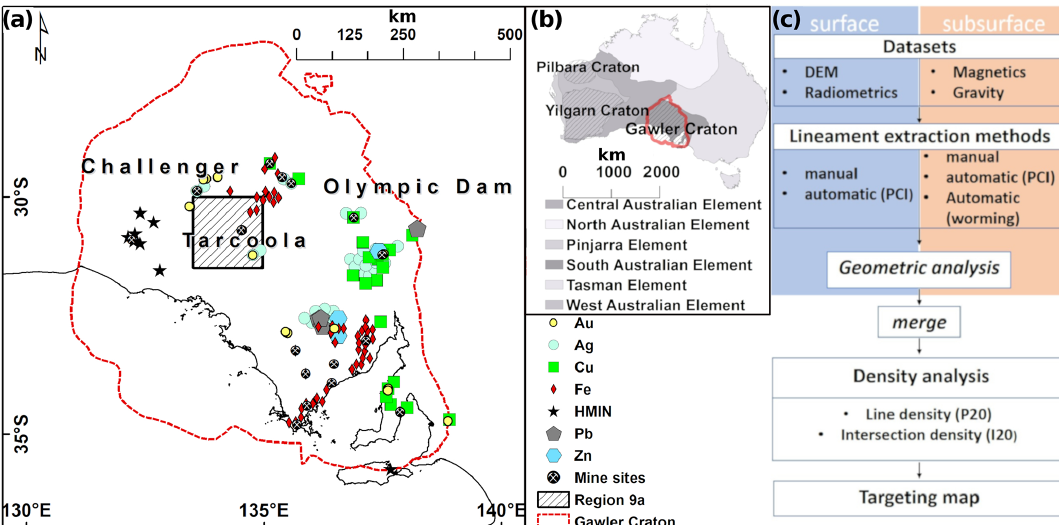
Figure 1. (a) Economic mineral occurrences in the Gawler Craton. The mineral commodities include Au, Ag, Cu Fe, HMIN (heavy minerals), Pb, and Zn. (b) Overview map of the Australian continent showing the major crustal blocks and the locations of mineral-rich Archean to Proterozoic tectonic provinces. The Gawler Craton spans across nearly the entire South Australian Crustal element. (c) Outline of the workflow applied in this study to obtain targeting maps from surface and subsurface datasets. The first step is to categorise the datasets based on their penetration depth into surface and subsurface signals. Lineaments are then extracted with the methods outlined in Sect. 3.3, 3.4, and 3.5. Note that the multi-scale edge detection (“worming”) is only applied to the magnetic and gravity data, manual segmentation was only performed on the DEM, and automatic lineament mapping with the PCI Geomatica LINE module was applied to all datasets. We performed a geometric analysis on the extracted lineaments to highlight the variability between the different methods (Fig. 11). Targeting maps are derived from computed line density and intersection density maps. The first step for obtaining these maps is to merge lineaments into a single dataset if the lineaments are extracted with the same method. This is performed for surface and subsurface lineaments respectively, i.e. extracted from the DEM, and the radiometrics with the LINE module of the PCI Geomatica software are merged into a single dataset representing the collated lineaments attributed to changes in surface topology and chemical composition. A summary of the merged data utilised is shown in Table 1. The density maps are then computed for datasets that comprise surface and subsurface lineaments (see Table 2). We visualise the targeting maps as colour coded line density maps that are contoured by the intersection density. Based on a defined threshold, potential targeting areas are then highlighted in these maps. A more detailed workflow diagram is included in Fig.